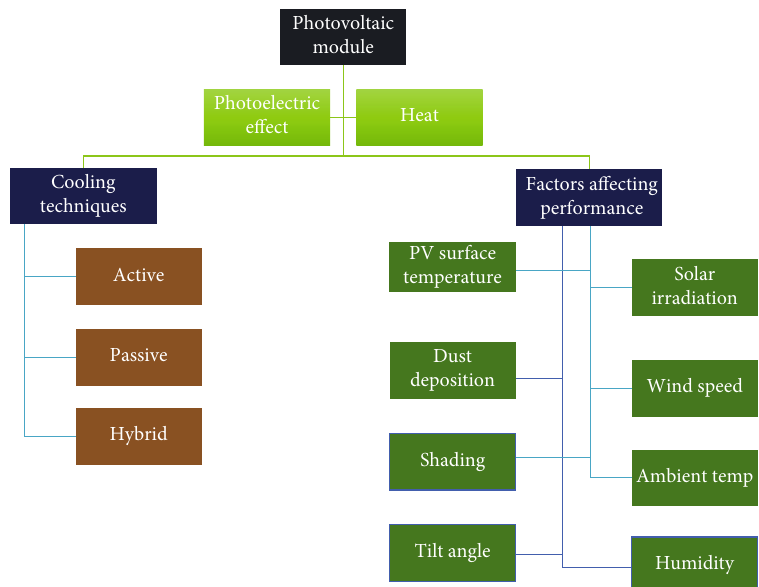
Figure 1: Factors in fl uencing module performance and cooling